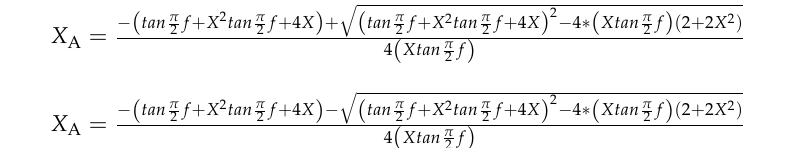
Figure 3. Equivalent schematic diagram of the main PA branch at the OBO